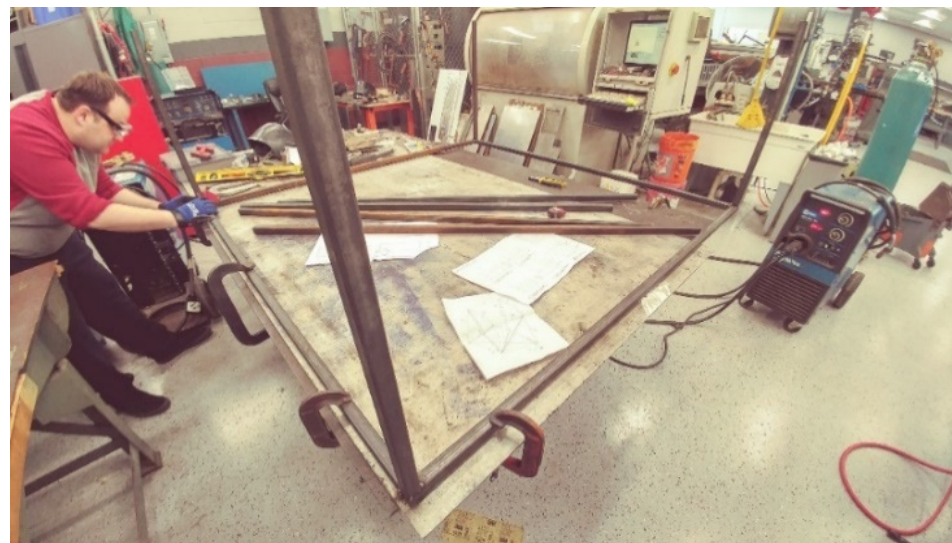
Figure 2. MMS research and design.